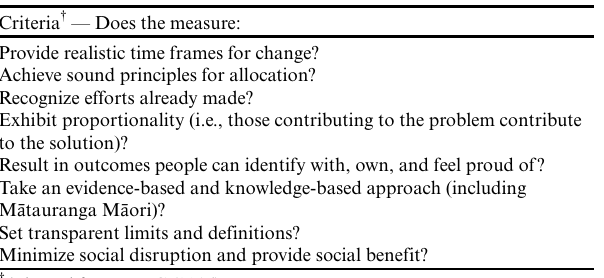
Table 3. Illustrative criteria for sharing the costs of change. Criteria † — Does the